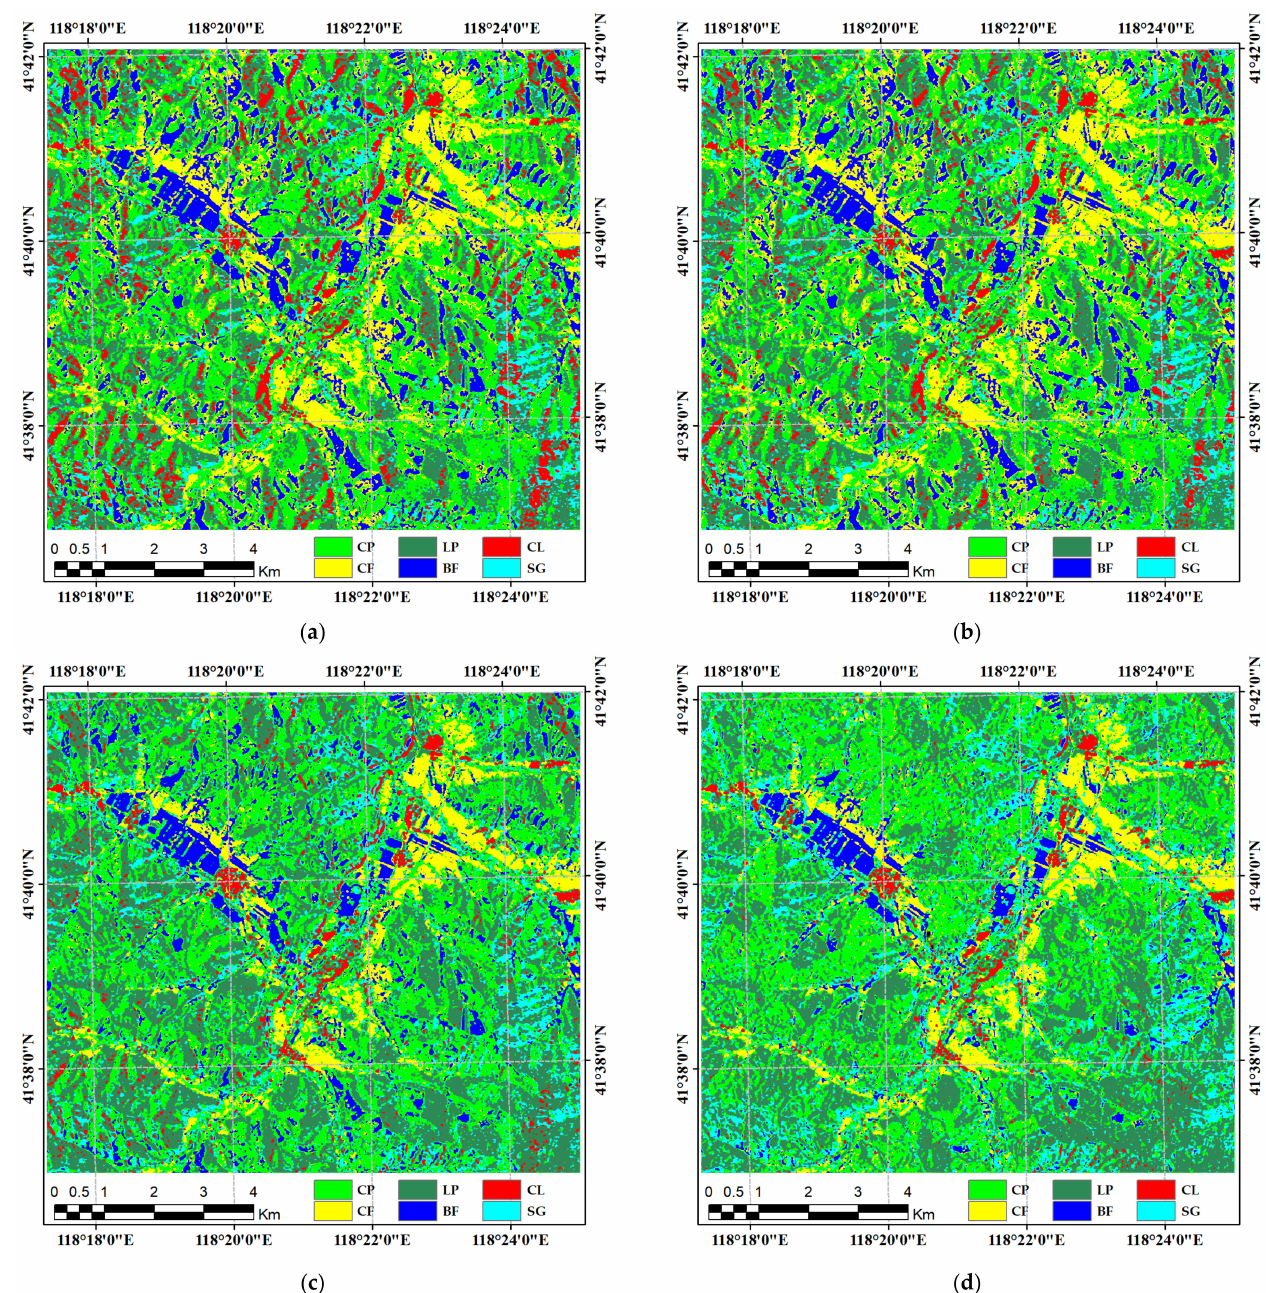
Figure 11. The classification result after each correction step: ( a ) GTC (i.e., no correction); ( b ) POA correction; ( c ) POA + ESA correction; ( d ) POA + ESA + AVE